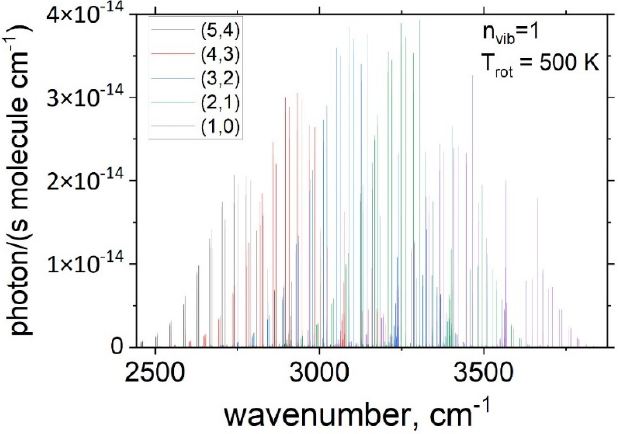
Figure 10. Theoretical emission spectra (cross sections) of OH for the 5 bands simulated using Equation (1) ( T R = 500 K, using a Lorentzian line profile of HMHM = 0.02 cm − 1 ) assuming the vibrational population n v =